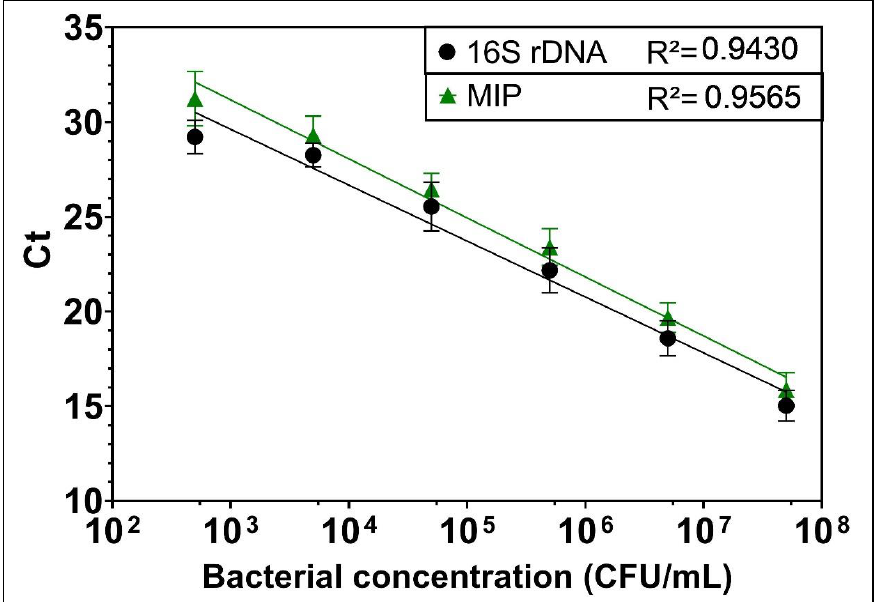
Figure 1. Correlation of Ct values derived from second derivative of PCR amplification using 16S ribosomal DNA universal bacterial primers and MIP gene primers specific for L. pneumophila with bacterial suspensions at different concentrations in microplate wells ( n = 15). The results were fitted for MIP and 16S DNA as Ct = 40.532 ± 3.117 × log(10) and 38.487 ± 2.953 × log(10), respectively. Error bars are shown to indicate standard deviation.